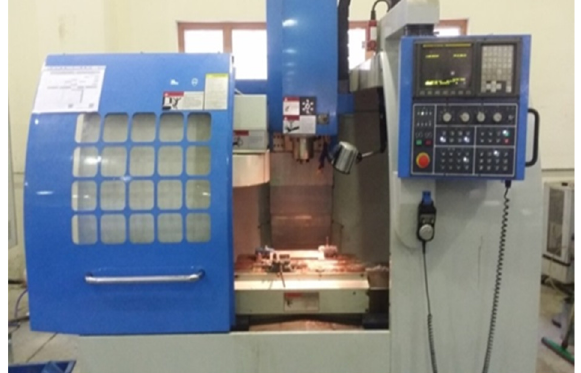
Fig. 2. CNC FANUC Series Oi-MB.